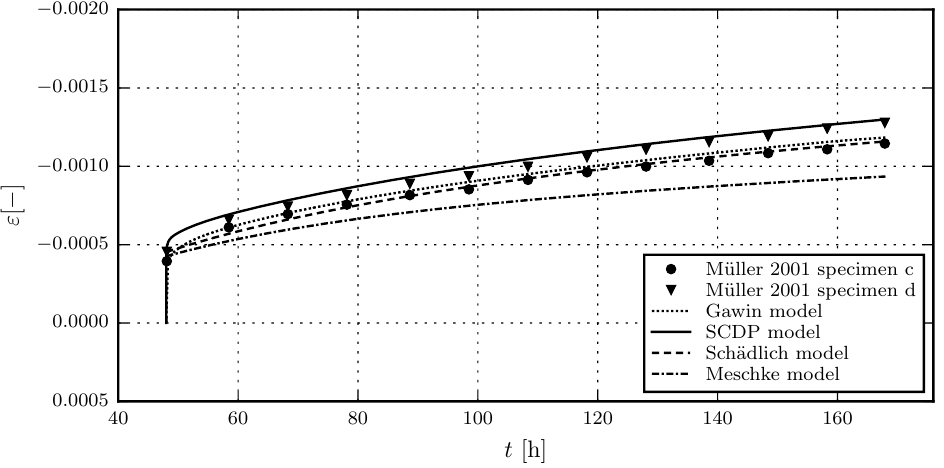
Figure 5. Evolution of the total strain in creep tests on unsealed specimens: Results of the calibration of the shotcrete models based on the test data from creep test series 4/2, load step 1, by Müller [17].